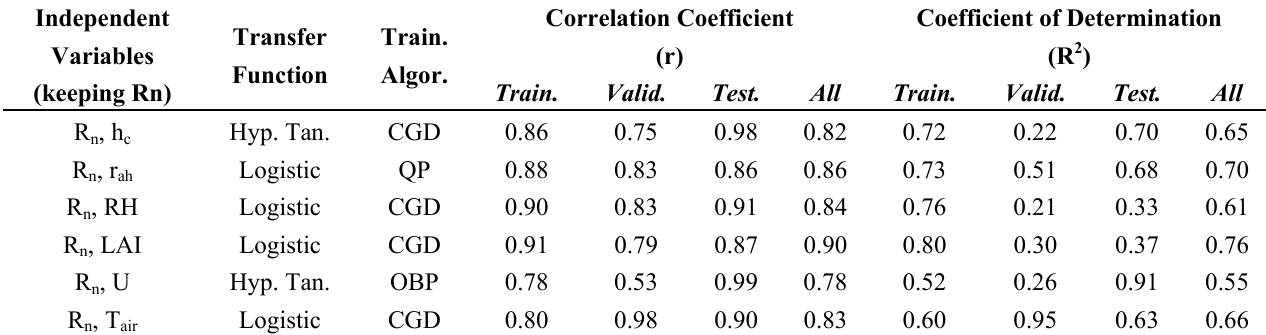
Table 5. Performance of ANN using combinations of two independent